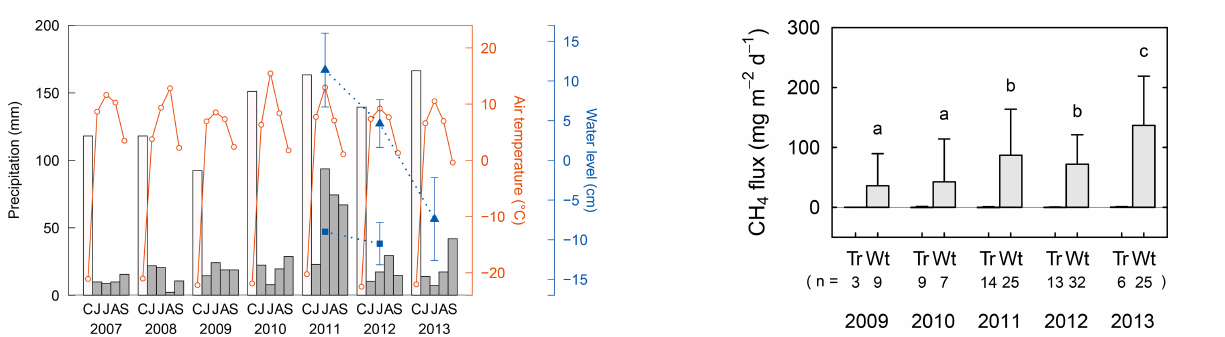
Figure 2. Interannual variations in precipitation (bars) and air tem- perature (solid lines) observed at a weather station at Chokurdakh for the cold season with snow cover (C: total from October in the previous year to May in the current year) and the warm season (JJAS), and water level (dotted lines) measured in wet areas of sedges (triangle) and sphagnum mosses (square). Water level was very low ( < − 12cm) in the wet area of sphagnum in 2013 and could not be measured. Error bars represent standard deviations. Methane flux was observed during the main summers (early July to early Au- gust) from 2009 to 2013.